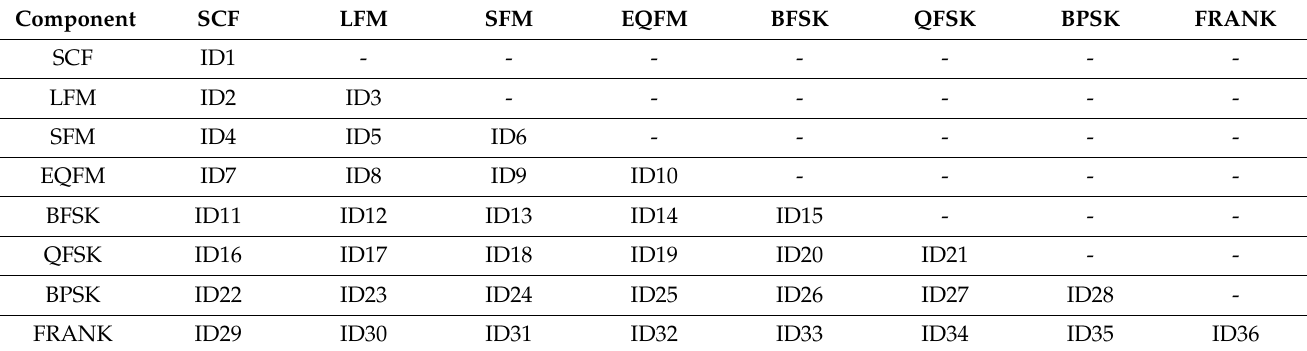
Table 3. The index information for the dual-component